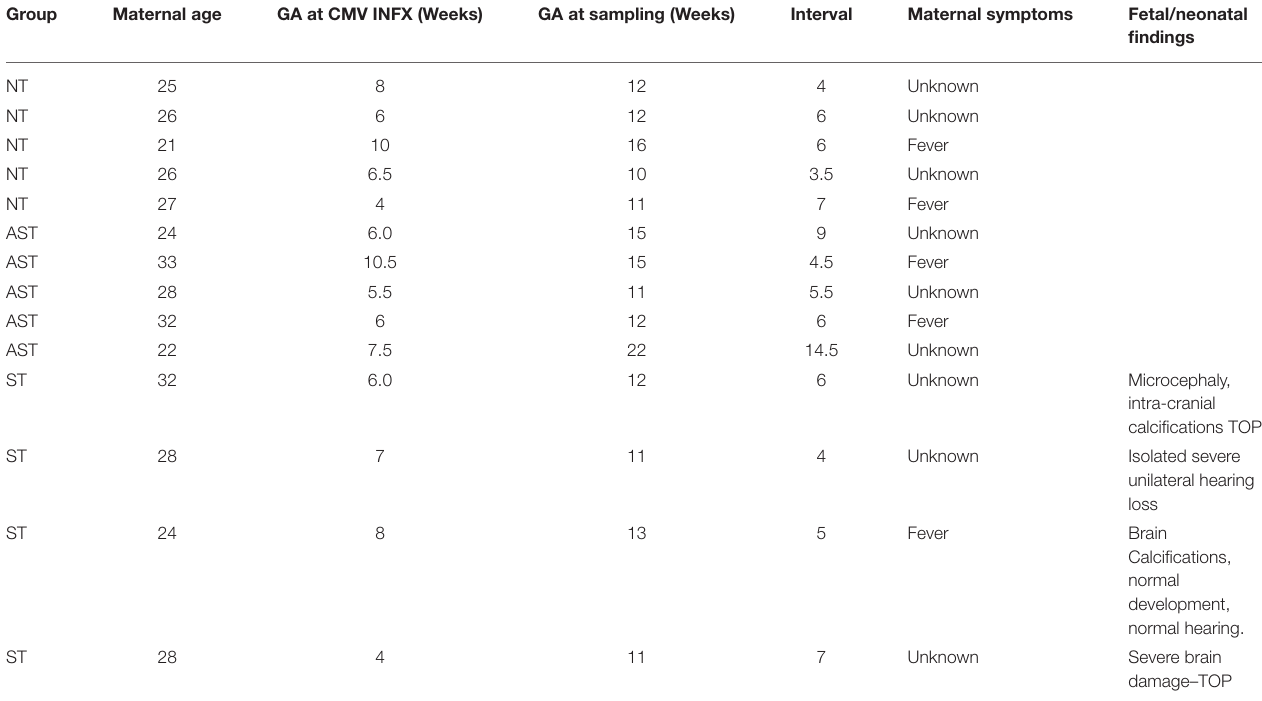
TABLE 1 | Clinical characteristics of nested case control subjects. Group Maternal age GA at CMV INFX (Weeks) GA at sampling (Weeks) Interval Maternal symptoms Fetal/neonatal